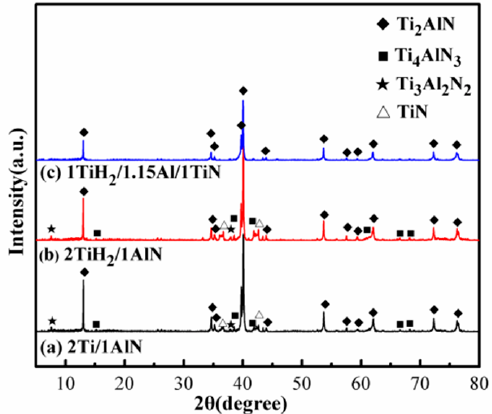
Figure 2. XRD patterns of ( a ) 2Ti / 1AlN; ( b ) 2TiH 2 / 1AlN; and ( c ) 1TiH 2 / 1.15Al / 1TiN prepared by microwave sintering for 30 min at 1250 °C.